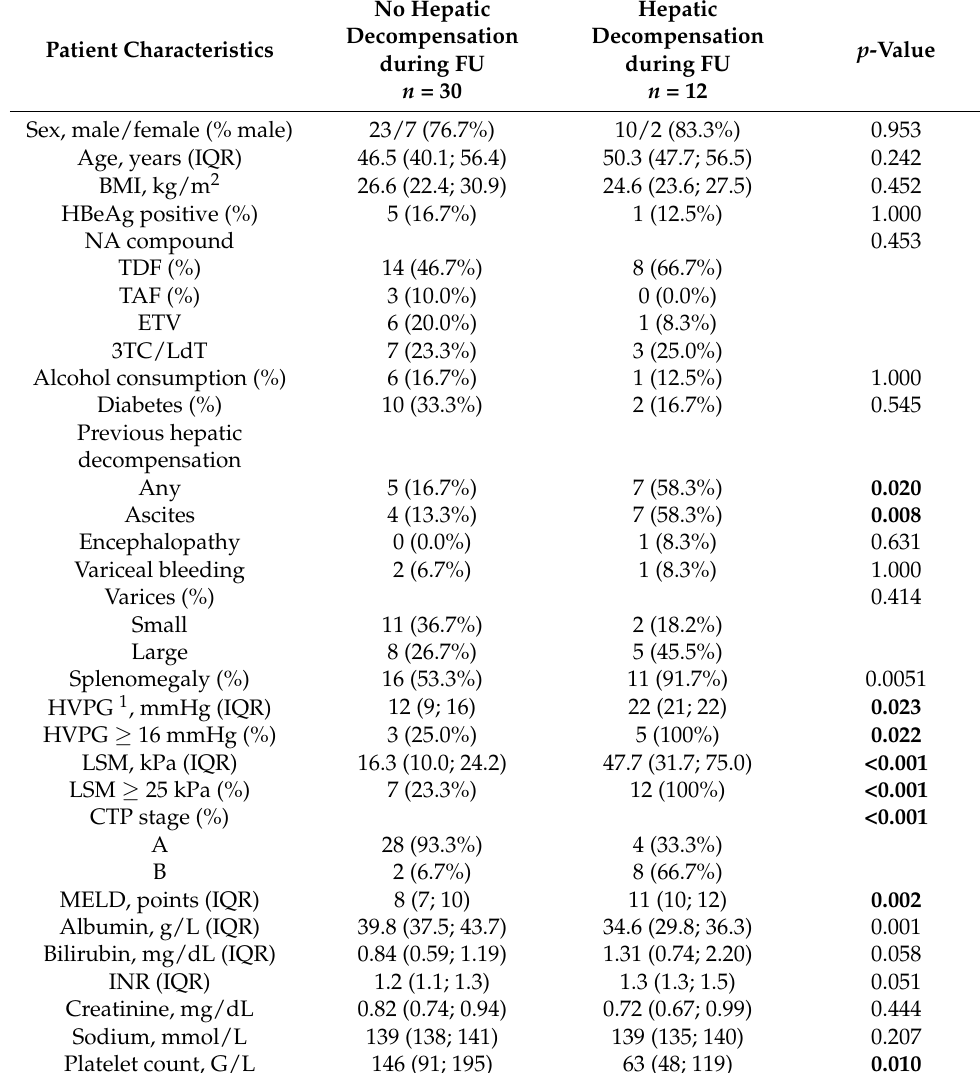
Table 1. Comparison of patient characteristics under long-term chronic NA therapy stratified by the incidence of hepatic decompensation during